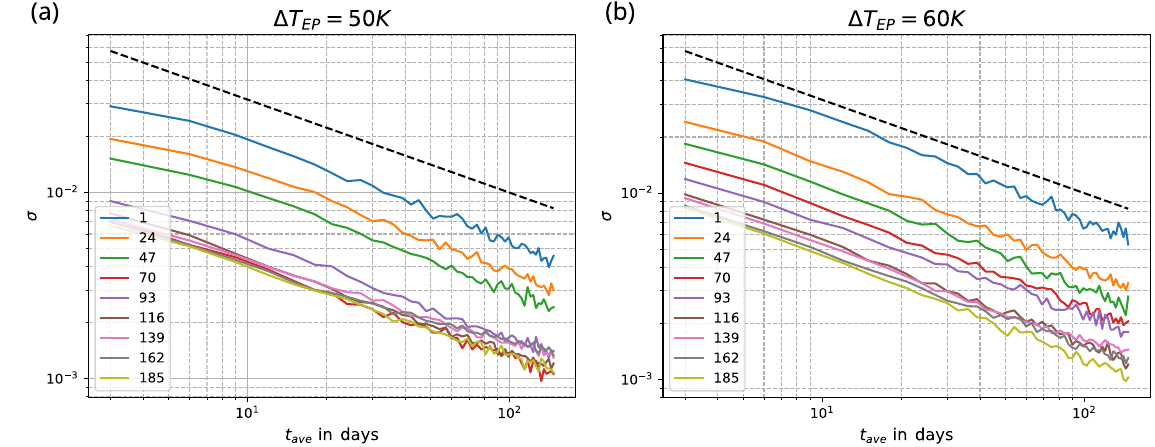
Figure A1. Standard deviation σ as a function of the block averaging length t ave for different Lyapunov exponents of the PUMA model. The Lyapunov index is shown in the legend. Panel (a) shows the results for a temperature gradient (cid:49)T EP of 50K, panel (b) for 60K. The black − 1 2 ave dashed line corresponds to t